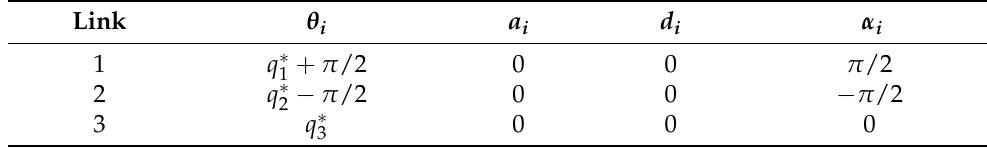
Table A1. DH Parameters for the Three-Axis Gimbal.